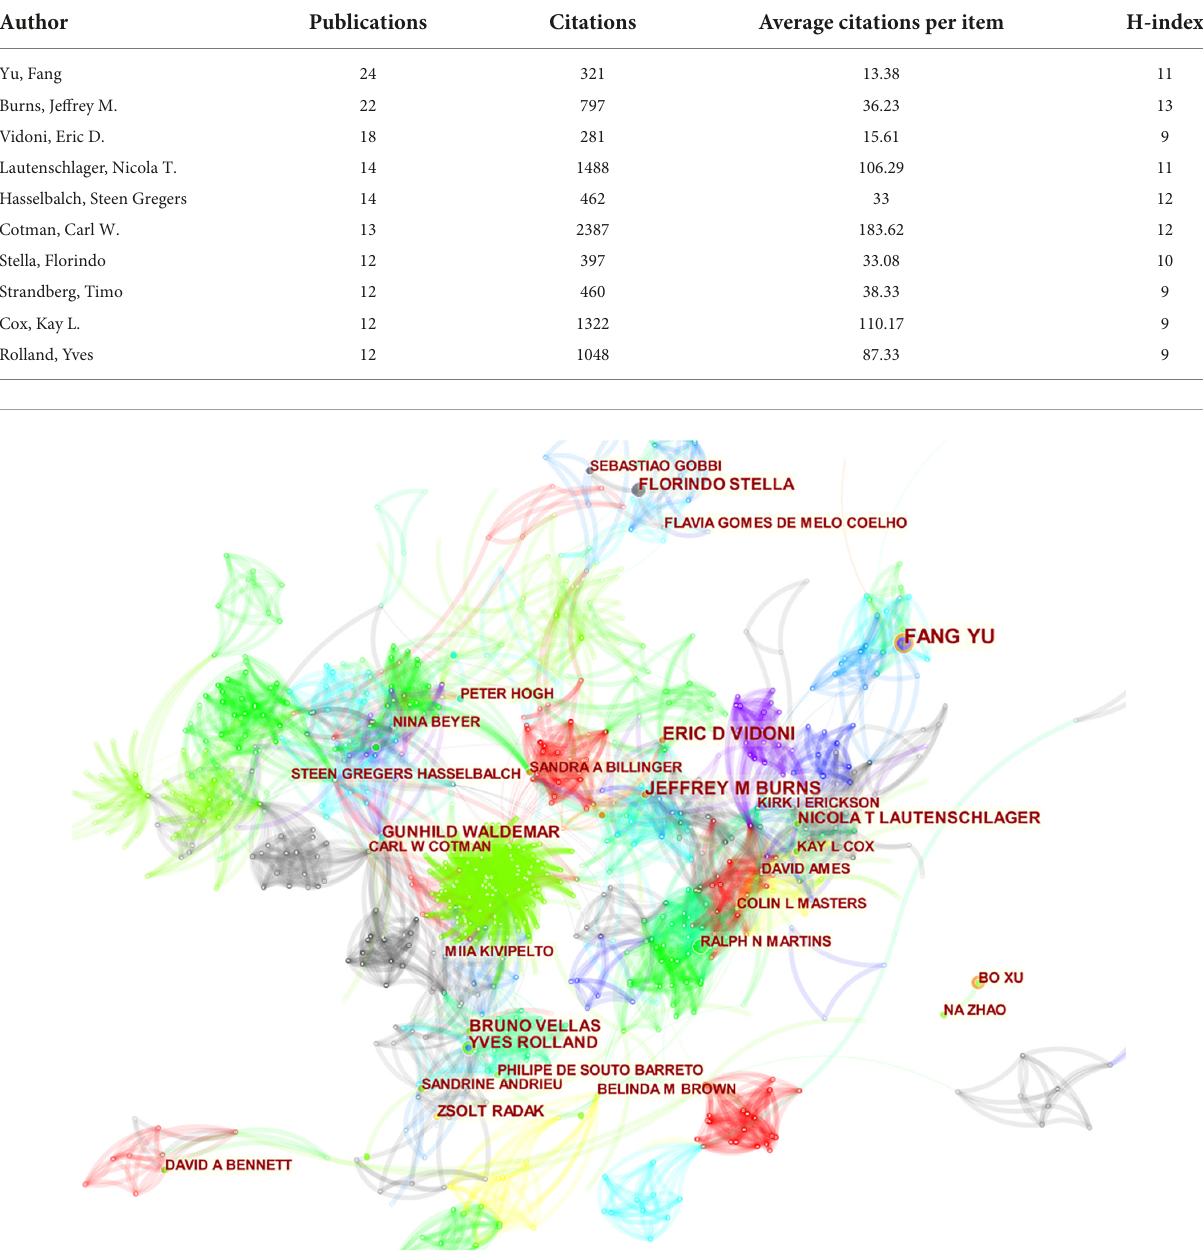
TABLE 3 Top 10 most productive authors.